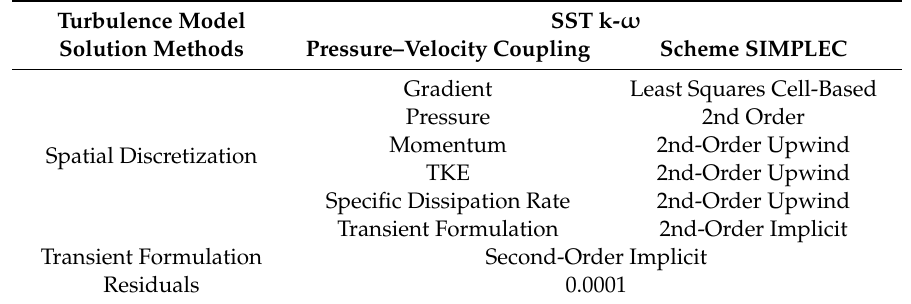
Table 1. ANSYS’s setups for both pure Computational Fluid Dynamics (CFD) and hybrid ANSYS model. Turbulence